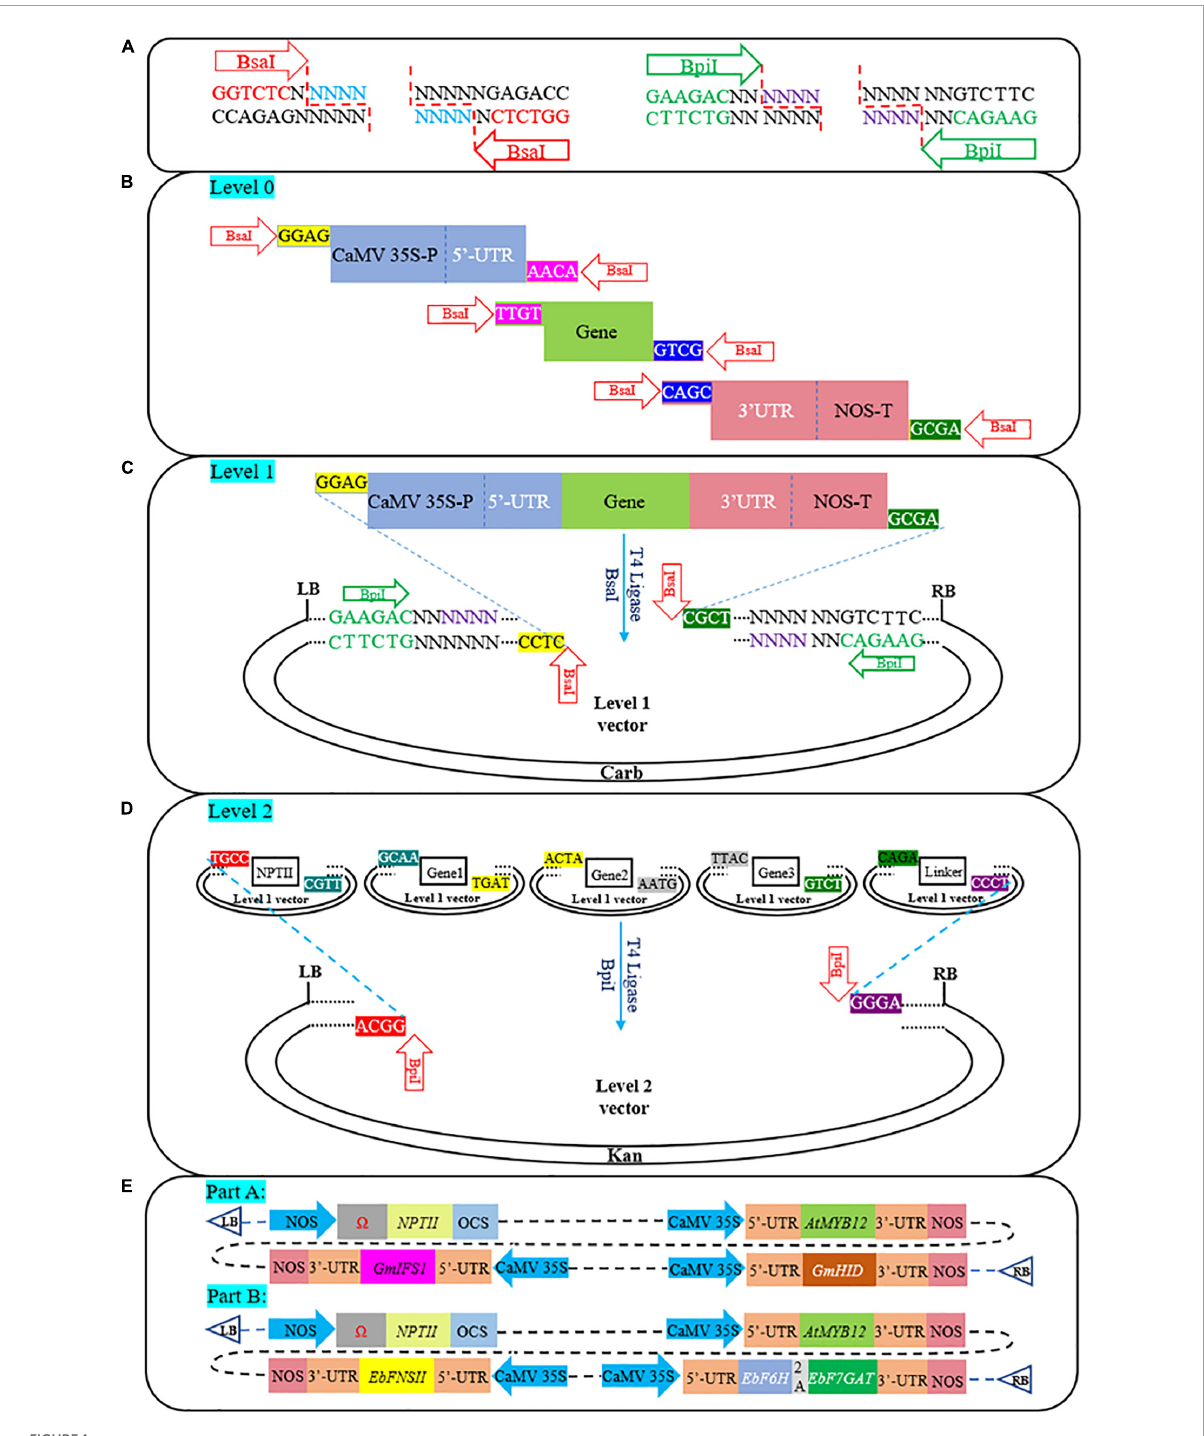
FIGURE1 A schematic illustrating the assembly of multigene constructs based on the GGC. (A) Recognition sequence, cleavage site, and post-cleavage overhangs of two type IIS restriction enzymes ( Bsa I and Bpi I). (B) The Bsa I recognition sites (GGTCTC) and specific fusion sites (e.g., GGAG and ACAA) on both sides of each Level-0 module (e.g., promoter, UTR, ORF, 2A, and terminator) were introduced by primers. (C) Level-1 module digestion-ligation process. Each expression cassette was assembled into Level-1 destination vectors. (D) The final Level-2 modules construction process. Multiple Level-1 modules formed the final vector via a one-step digestion-ligation reaction of Bpi I and T4 ligase. (E) Schematic diagram of T-DNA regions containing pathway genes involved in the synthesis of genistein and scutellarin. Part A, genistein; Part B, scutellarin; NPTII, aminoglycoside phosphotransferase from Tn5; (cid:127) , tobacco mosaic virus 5 (cid:48) -leader sequence. 2A, Thosea asigna virus